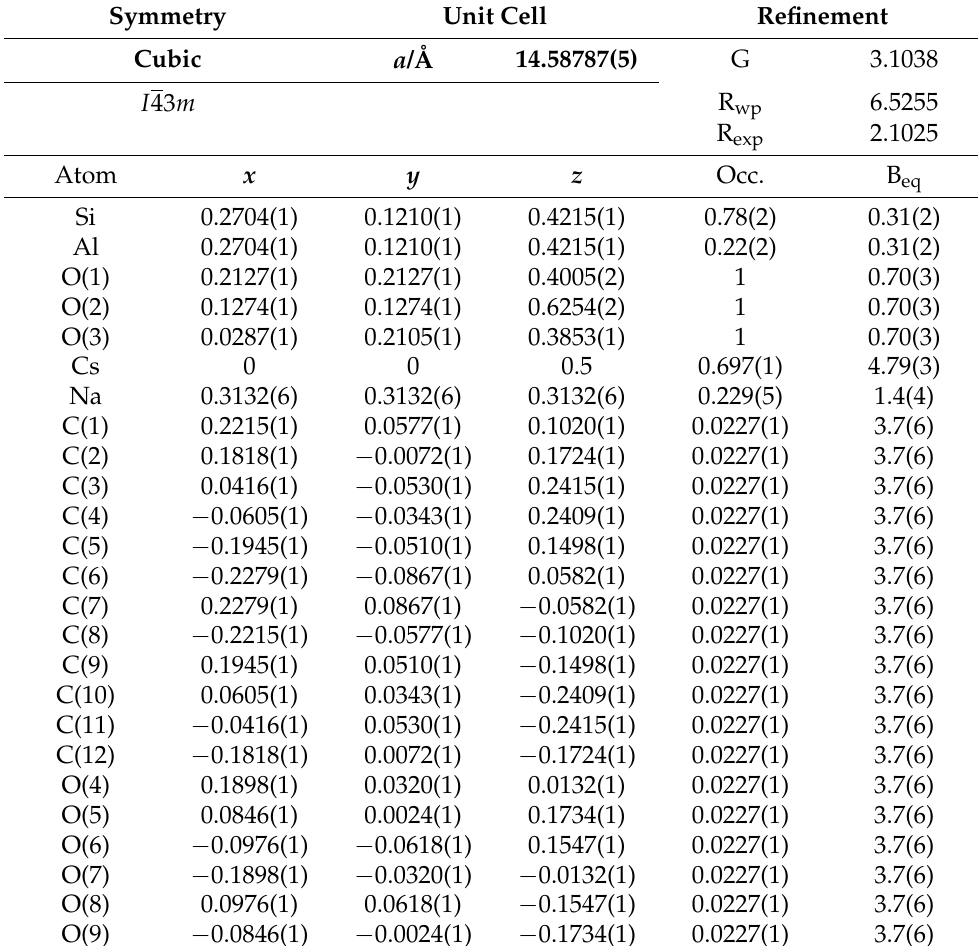
Table 4. Final refined unit cell parameters and crystallographic sites for the filled zeolite RHO sample. ‘Occ.’ refers to the fractional occupancy of the relevant crystallographic site. Error in